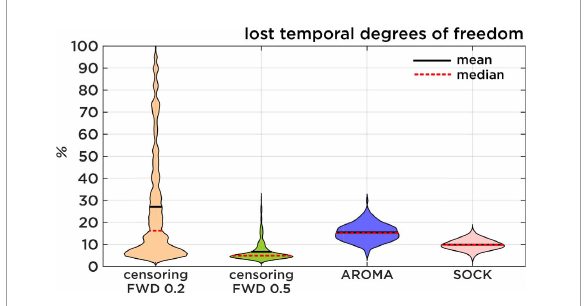
FIGURE3 Lost temporal degrees of freedom. Comparison of the percentage of data that is lost resulting from each regression approach. Censoring results are displayed first with a theoretical FWD cut-off of 0.2 mm and then with the slightly more lenient 0.5 mm FWD cut-off. Censoring loss is induced by discarding timepoints of high motion, while AROMA and SOCK loss is induced by the number of ICA components classified as